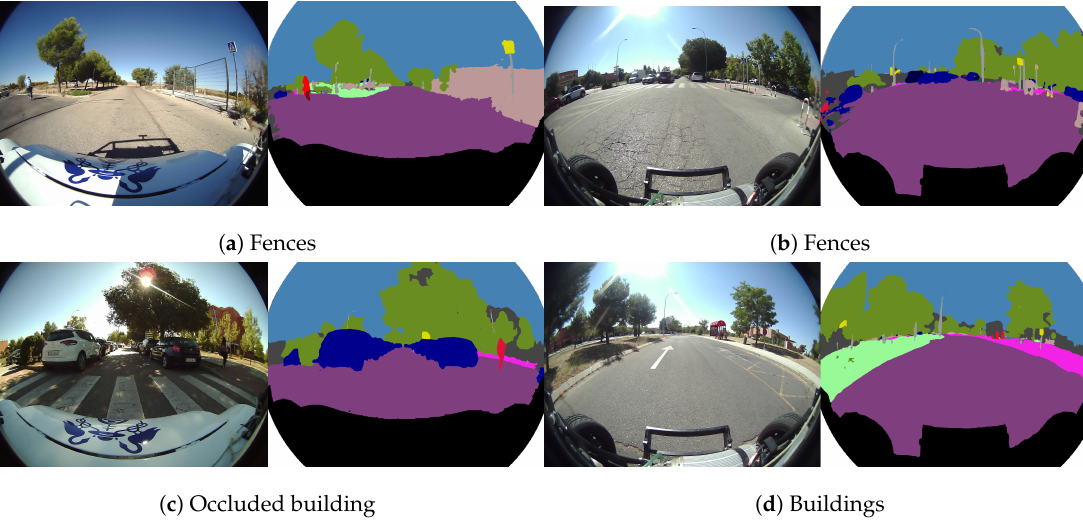
Figure 15. Real fisheye camera semantic segmentation examples for the vehicle group.